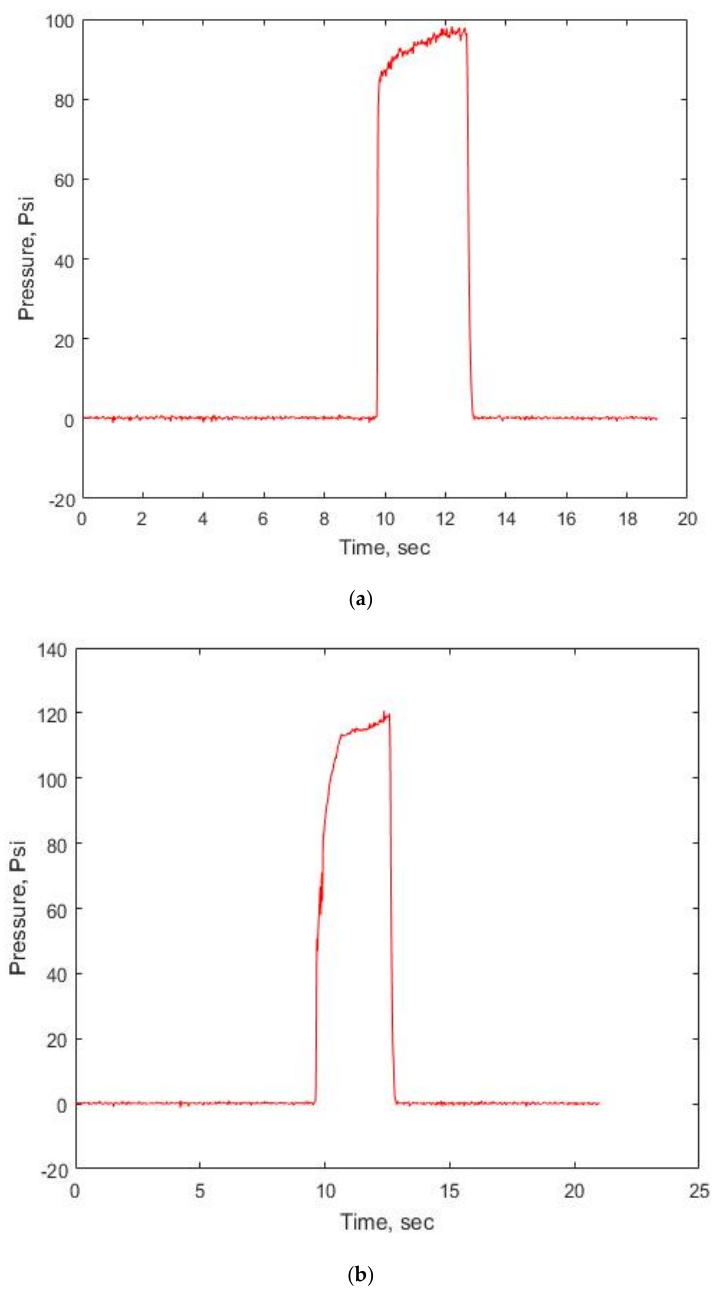
Figure 12. Pressure-time data using ( a ) shower head injector and ( b ) multi-angle diverging injector for paraffin wax. para ffi n